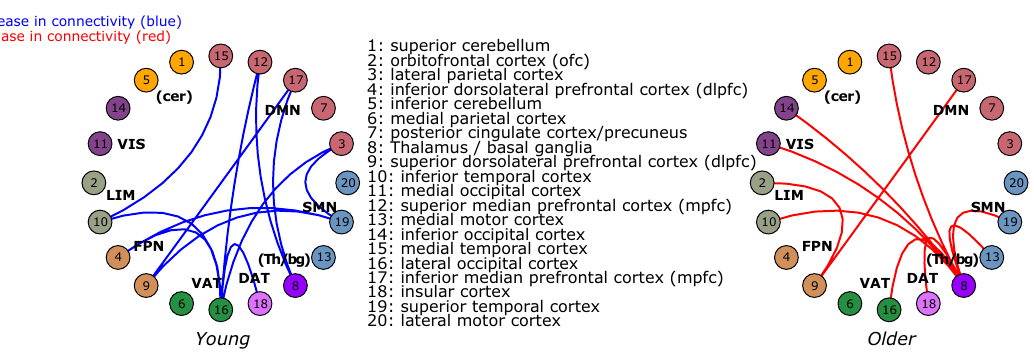
Figure 4. Significant age-group differences in connectivity for the N1 to N2 sleep stage transition. This graph represents significant interaction changes in functional connectivity between the clusters (two-way directionality) obtained from the data driven parcellation (circles with numbers) for the N2 to N1 sleep stage transition. Blue lines (left panel) indicate stronger decreases in connectivity in younger as compared to older individuals. Red lines (right panel) indicate significant connectivity increases in the older groups only. The seven Yeo’s large-scale networks partitioning the brain are presented with different colors: The default-mode network (DMN); the sensorimotor network (SMN); the dorsal attentional network (DAT); the ventral attentional network (VAT); the l frontoparietal network (FPN); the limbic network (LIM) in green and the visual network (VIS). We added the inferior and superior cerebellum (cer) and thalamus/basal ganglia (Th/bg) clusters (see supplementary material for more details on clusters’ individuals, younger participants showed larger connectivity decreases between specific clusters of the ventral attentional network (VAT; lateral occipital cortex), sensorimotor network (SMN; superior temporal cortex), default-mode network (DMN; inferior prefrontal, superior median prefrontal, medial temporal), limbic network (LIM; inferior temporal cortex), frontoparietal network (FPN; dorsolateral prefrontal cortex), and thalamus/ basal ganglia (Th/bg) (Fig. 4, left panel). As illustrated by the right panel of Figs. 4 and 5, compared to the younger participants, older ones show significant increases in connectivity in N2 vs. N1 between the thalamus/basal ganglia (Th/bg) and specific clusters of the sensorimotor network (SMN; superior temporal cortex, median motor), default-mode network (DMN; median temporal cortex), visual network (VIS; median and inferior occipital), limbic network (LIM; inferior temporal cortex) and ventral and dorsal attentional networks (VAT; lateral occipital cortex and DAT; insular cortex). Older individuals also show higher connectivity in N2 vs. N1 between the frontal clusters of the frontoparietal network (FPN; superior dorsolateral prefrontal cortex), the limbic network (LIM; orbitofrontal cortex) and the default-mode network (DMN; median prefrontal cortex). One of the functional links between frontal clusters (frontoparietal network-FPN with default-mode network-DMN) is in fact, not only significantly different between groups, but shows opposite effects in the young (decrease in functional connectivity) and in